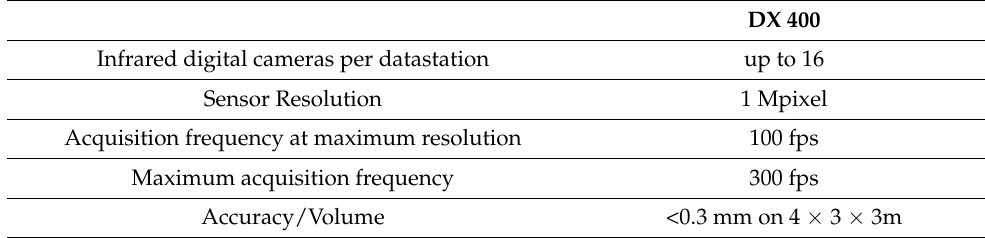
Table A4. Motion capture system technical specifications (BTS srl, SMART-D)